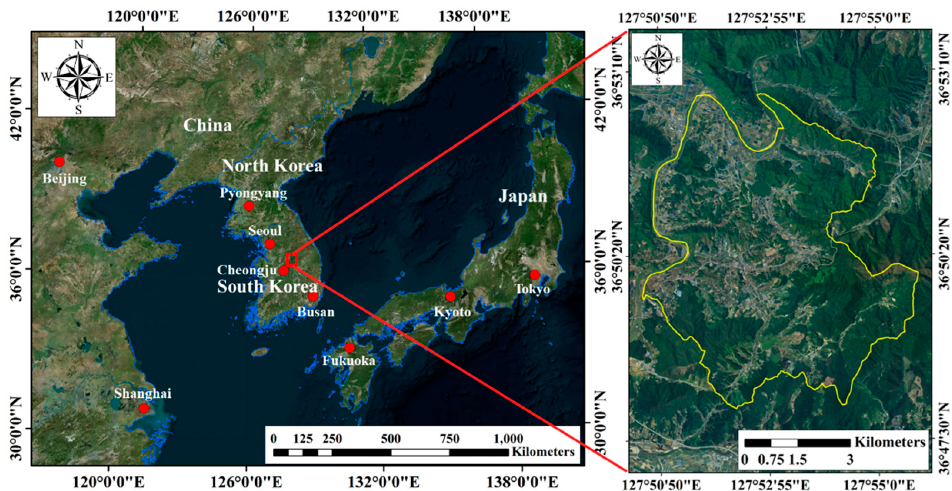
Figure 1. The location of the study area. In the figure on the right, the yellow line indicates the boundary of Gammul-myeon, the study area.